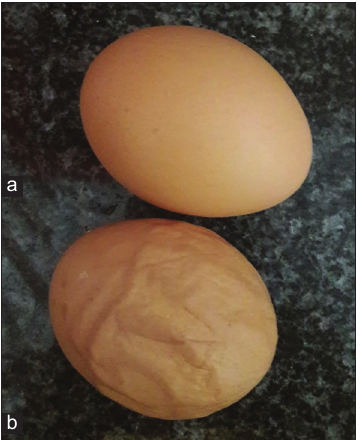
Figure-1: (a) Normal egg and (b) Egg drop syndrome egg abnormalities (personal